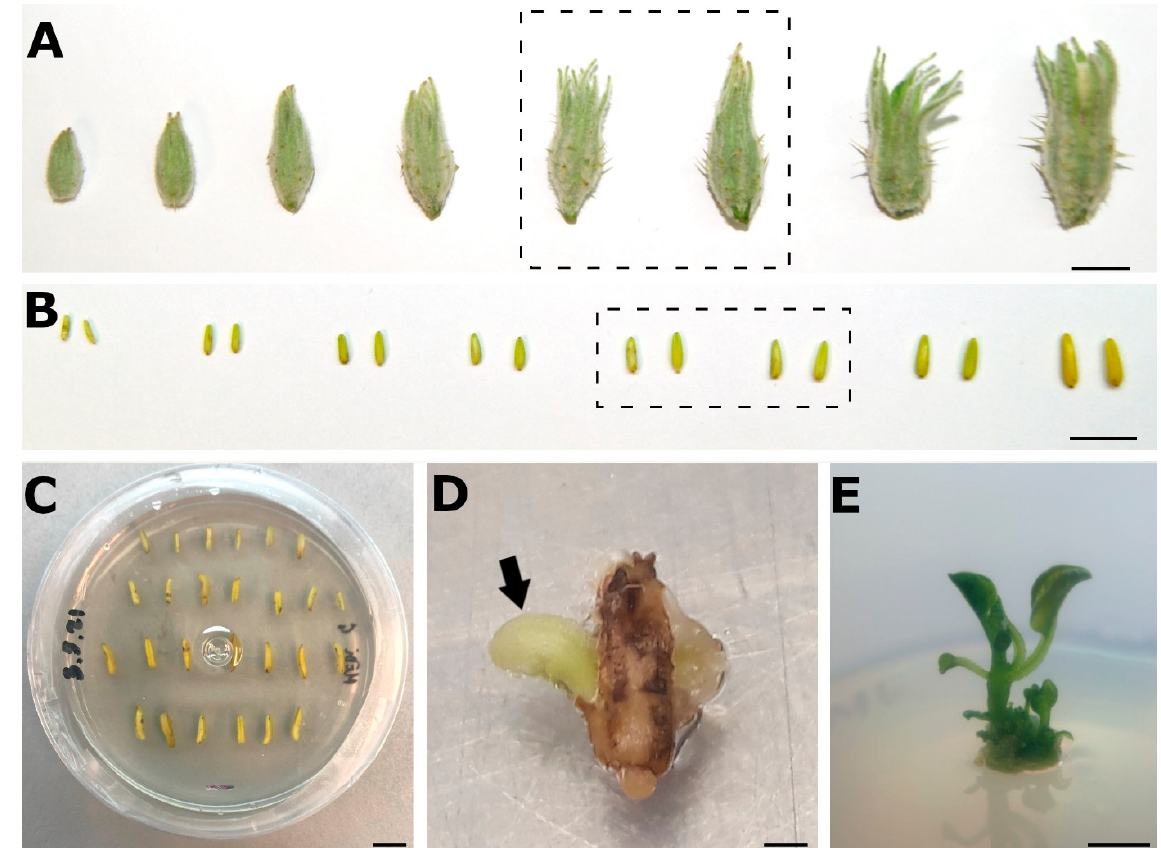
Figure 1. Anther culture in eggplant. ( A ). Range of developing eggplant floral buds. Developmental stages suitable for anther culture are boxed. ( B ). Range of eggplant anthers contained in the developing anthers shown in A. Anther sizes suitable for anther culture are boxed. ( C ). Anthers cultured in vitro on induction medium. ( D ). Microspore-derived embryo (arrow) emerging from a two month-old necrosing anther. ( E ). Eggplant plantlet produced in vitro from a germinated microspore ‐ derived embryo. Bars: A–C, E: 1 cm; D: 1 mm.